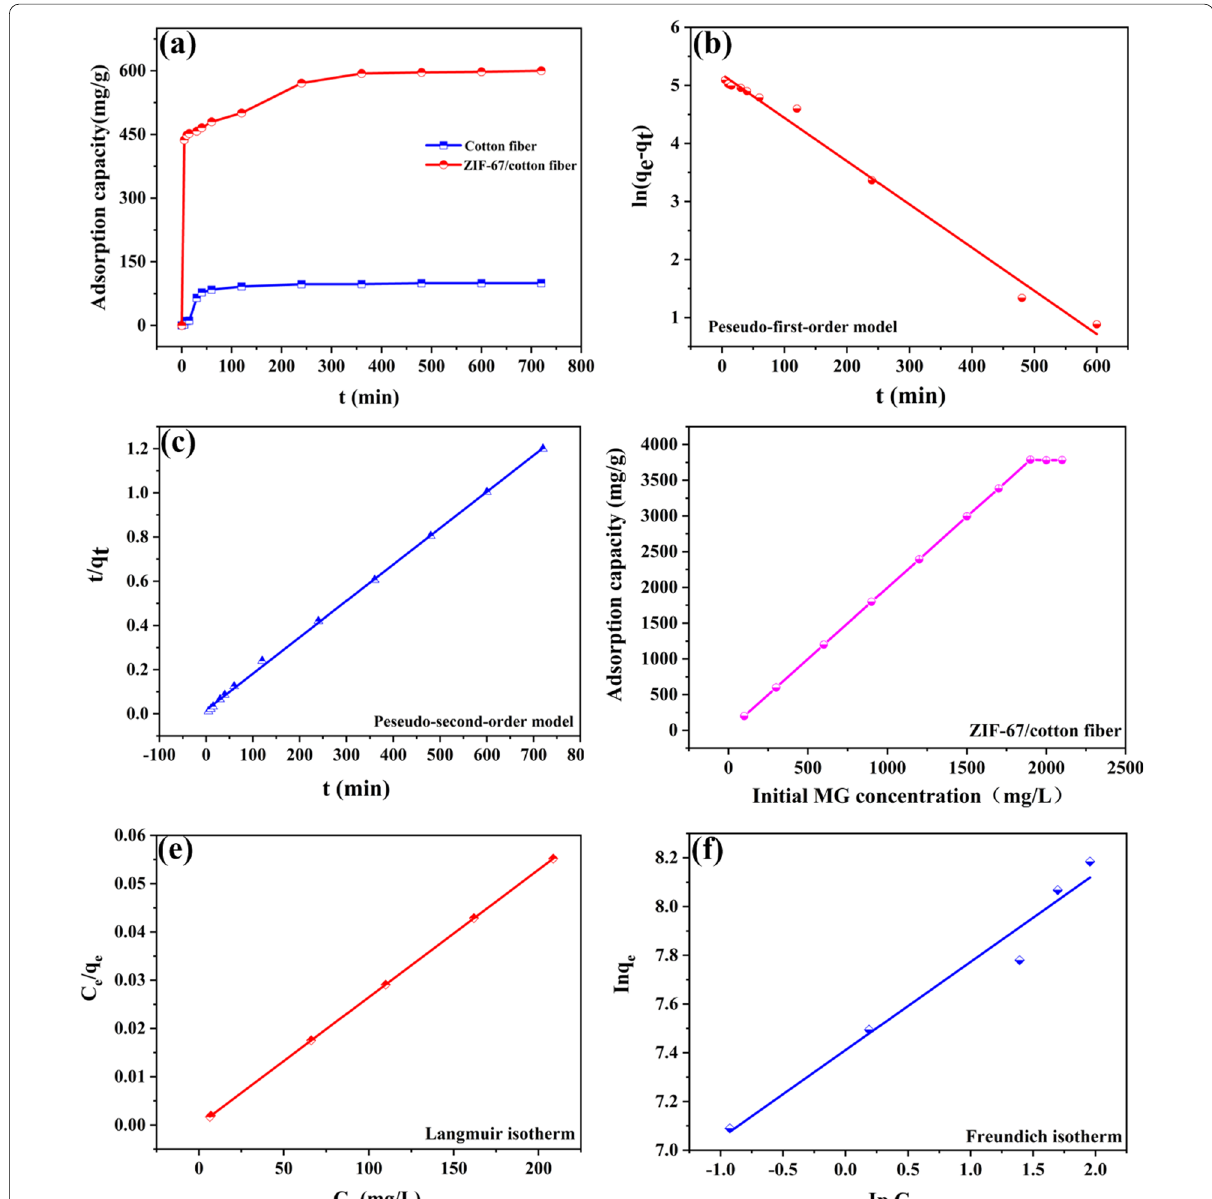
Fig. 5 Effect of contact time on the adsorption capacity of the ZIF-67/cotton fibers towards MG ( a ), the pseudo-first-order kinetic model ( b ) and pseudo-second-order kinetic model ( c ) for adsorption of MG by the ZIF-67/cotton fibers (adsorption conditions: mass of adsorbent, 100 mg; initial dye concentration, 300 mg/L; volume of dye solution, 200 mL); effect of initial MG concentration on the adsorption of MG onto ZIF-67/cotton fibers ( d ); Langmuir ( e ) and Freundlich ( f ) isothermal models for the adsorption of MG by the ZIF-67/cotton fibers (adsorption conditions: mass of adsorbent, 10 mg; initial dye concentration, 100–2100 mg/L; volume of dye solution, 20